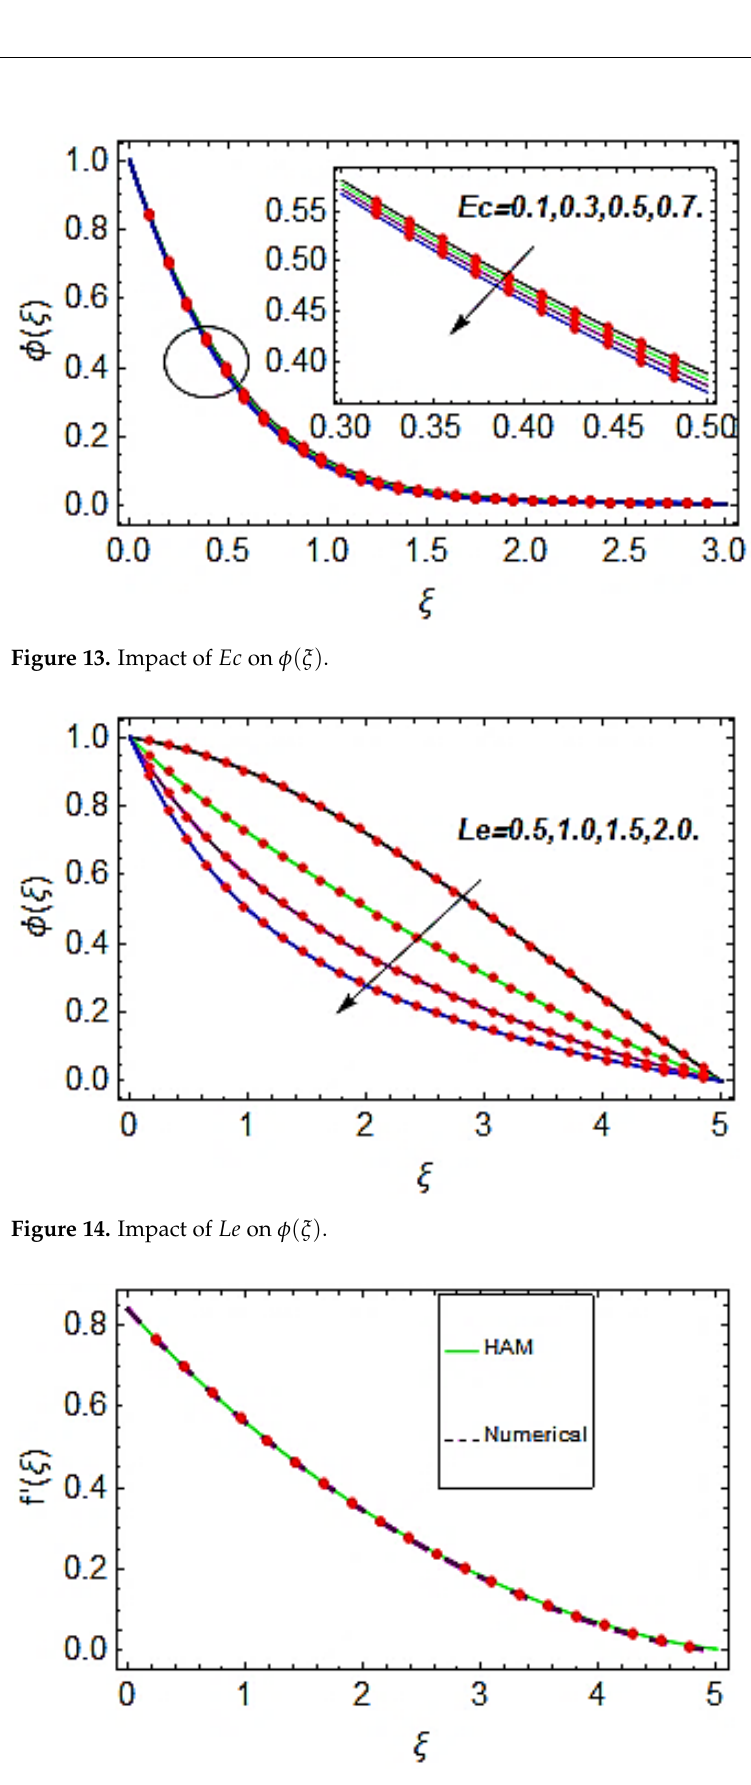
Figure 15. Assessment of HAM and numerical method for